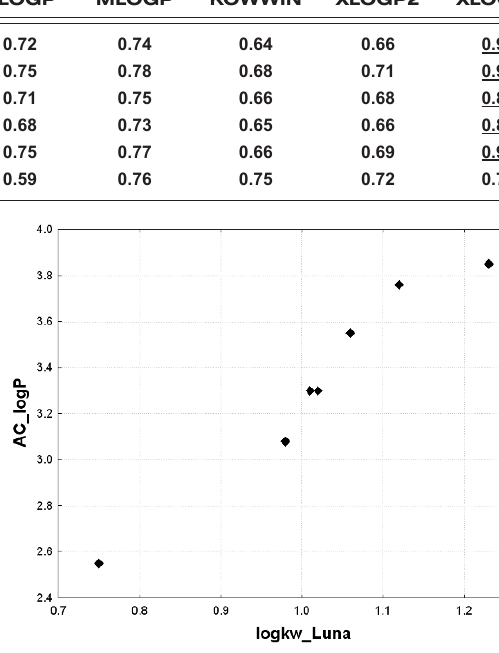
Figure 3. Example of correlation between determined (logkw_Luna) and calculated lipophilicity (AC_logP) for triazoloacridinones with statistical significance level p = 2×10 -4 .